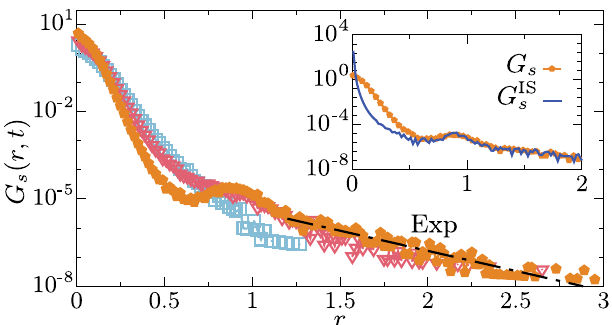
FIG. 7. Heterogeneous dynamics at early times. van Hove r; t Þ in 3D at the time distribution of particle displacements G s ð when Δ IS ð t Þ ¼ 6 × 10 − 3 (dash-dotted line in Fig. 3) for T ¼ 0 . 095 , 0.08, and 0.059 [same legend as in Fig. 1(a)]. The dash-dotted line is an exponential fit of the tail of the distribution at the lowest temperature. The inset compares the van Hove distributions computed at T ¼ 0 . 059 either from real displace- ments or from the visited inherent structures